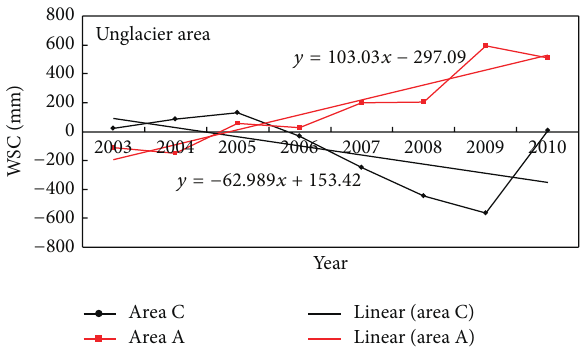
Figure 10: WSC of nonglaciated areas of A and